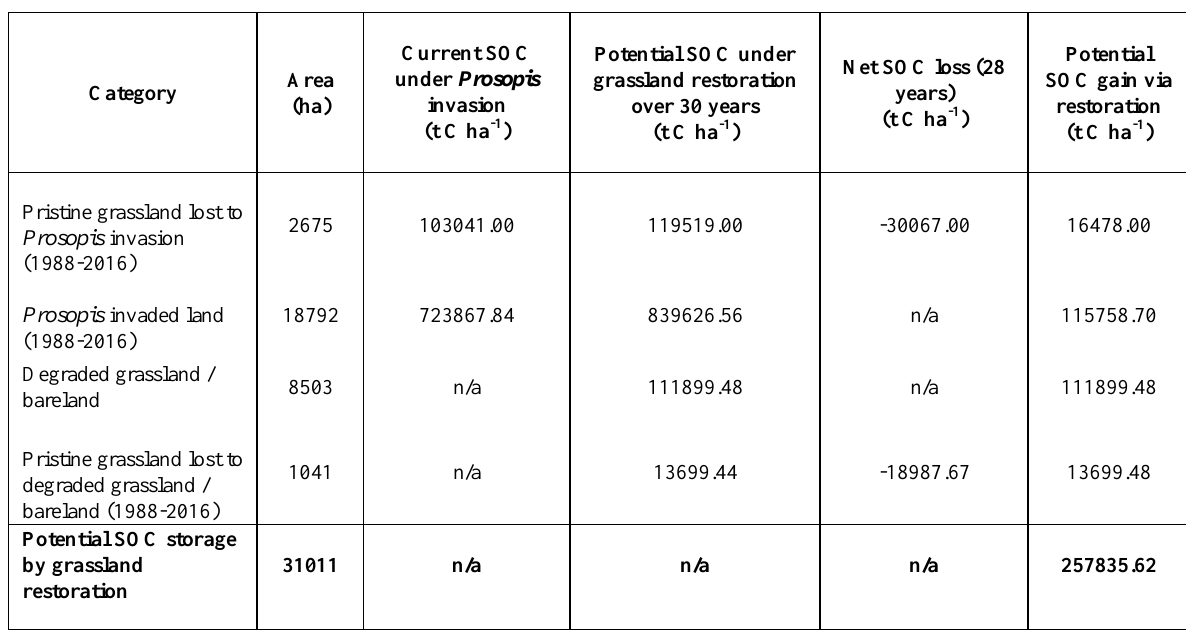
Table 1. Potential soil organic carbon storage through grassland restoration of currently Prosopis invaded and degraded land over the next 30